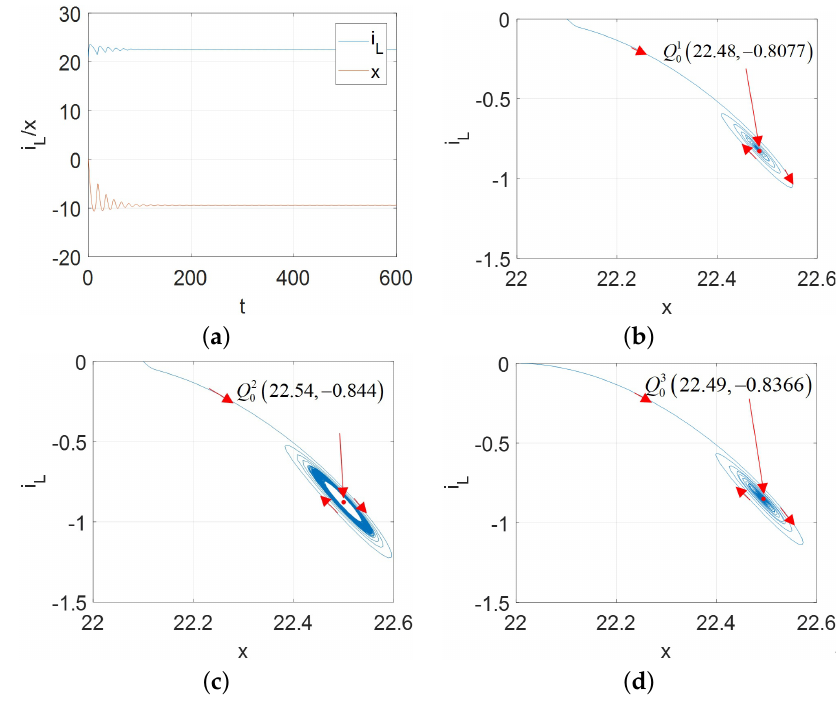
Figure 20. v 2 (cid:101) [ − 13.42, − 13.05 ] and initial condition [ x ( 0 ) , i L ( 0 )] = [ 10,0 ] for A = A FL : ( a ) x ( t ) and i L ( t ) for v = − 13.5 V; ( b ) stable limit cycle converges to Q 1 ( c ) stable limit cycle corresponding to the periodic waveforms for v 1 = − 13.3 V; ( d ) stable limit cycle converges to Q 3 (22.49, –0.8366) for v = − 0